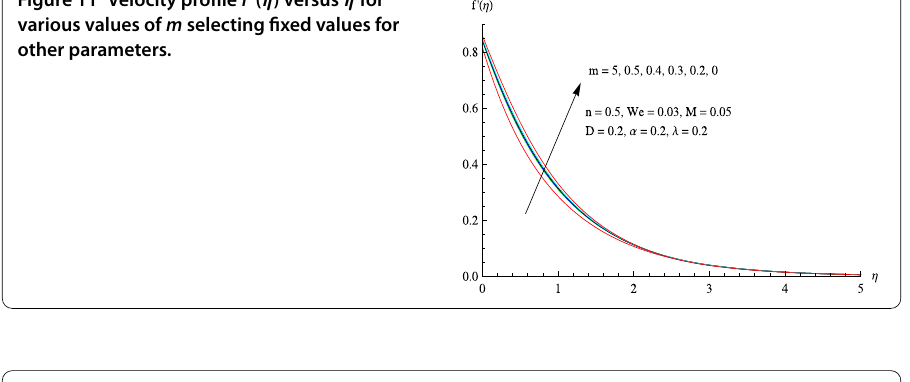
Figure 12 Velocity profile f (cid:2) ( η ) versus η for various values of M selecting fixed values for other parameters.